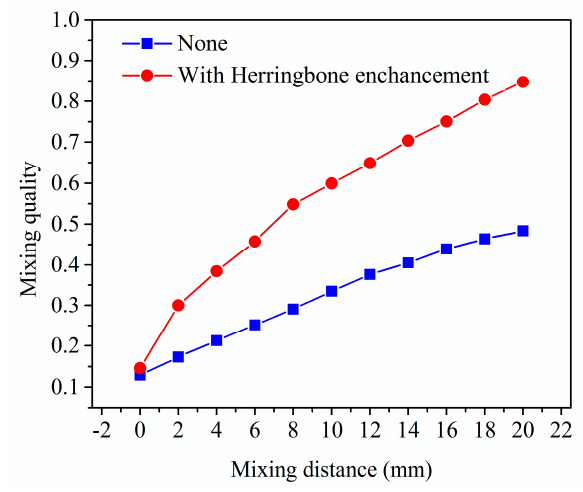
Figure 3. Comparison of mixing quality with and without herringbone structure. Red is the mixing quality along the main channel with herringbone enhancement, while blue is the mixing quality without any enhancement pattern.